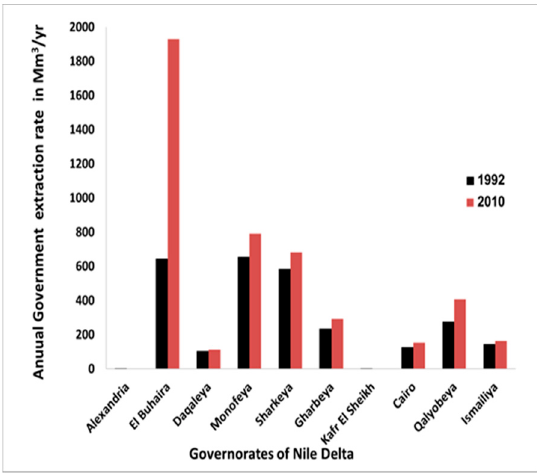
Figure 4. The distribution of the abstraction wells.